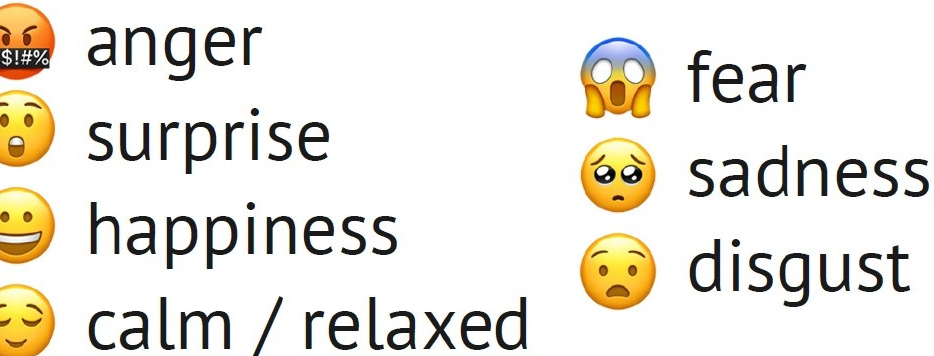
Figure 1. The emoji used to define the user’s moods associated with the Environment sticky notes.